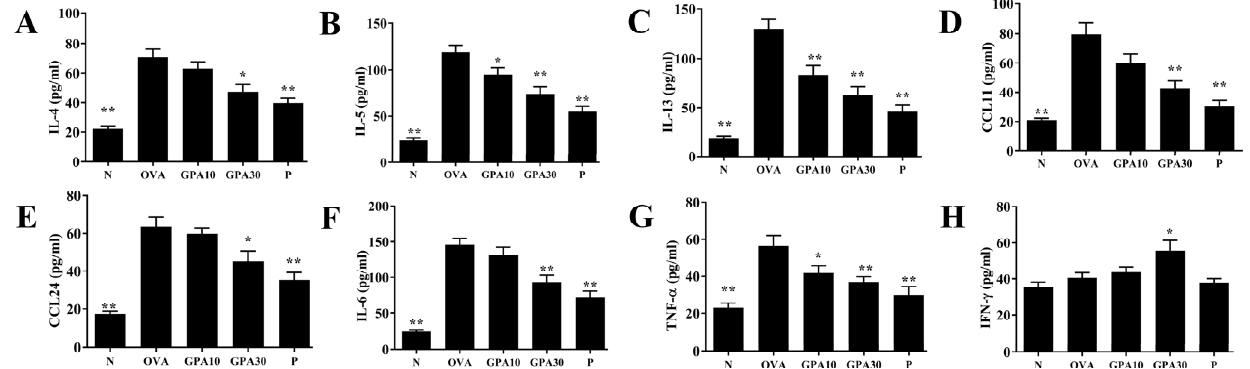
Figure 3. Gypenoside A (GPA) regulates BALF cytokine and chemokine levels. ( A ) IL-4, ( B ) IL-5, ( C ) IL-13, ( D ) CCL11, ( E ) CCL24, ( F ) IL-6, ( G ) TNF- α , and ( H ) IFN- γ as measured by ELISA. The